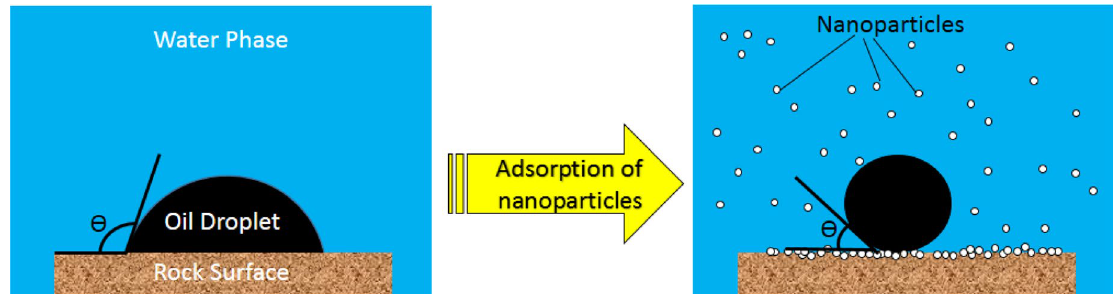
Fig. 2 Wettability alteration due to adsorption of nanoparticles on the surface of